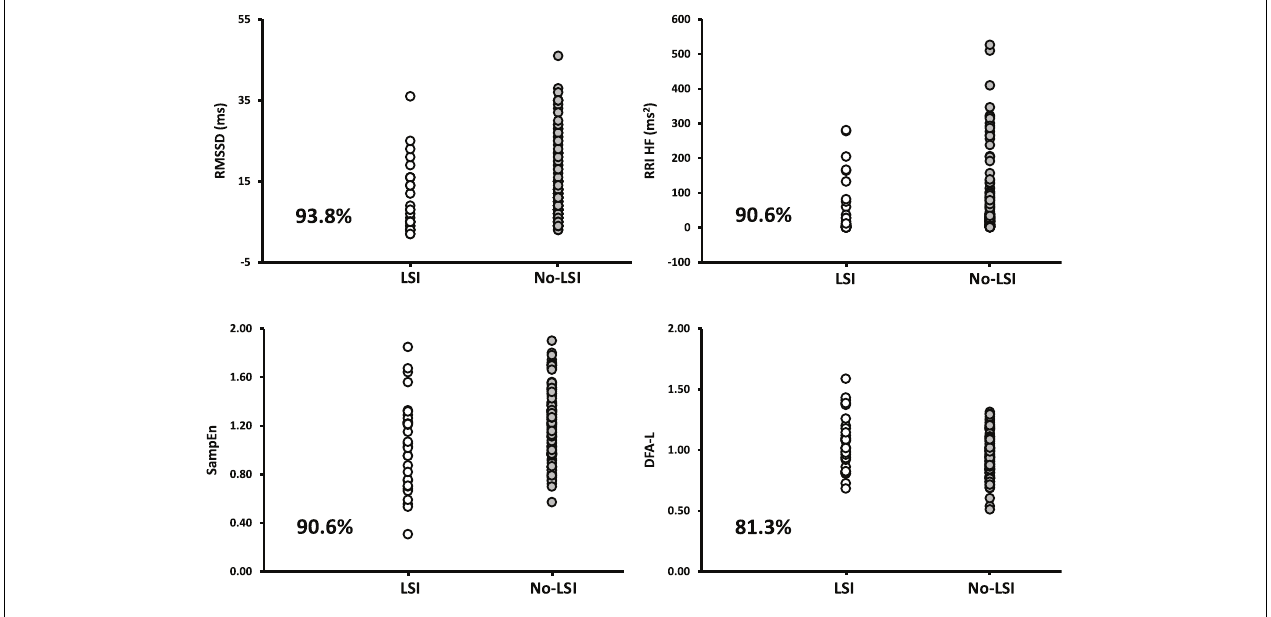
range of the No-LSI group are presented in each plot. RMSSD, R–R intervals root mean squared SD (a time domain metric); RRIHF, R–R intervals high frequency (a frequency domain metric); SampEn, sample entropy (a non-linear metric); DFA-L, detrended fluctuations analysis – long range correlations (a non-linear metric). From Rickards et al.